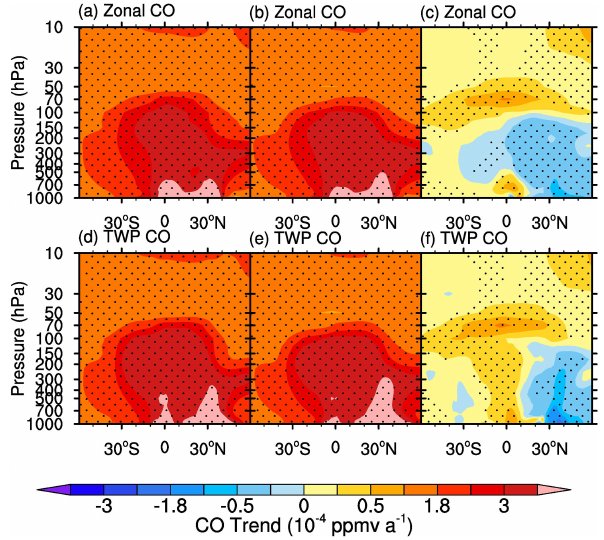
Figure 10. Latitude pressure cross sections of the trends of (a–c) the zonal mean CO concentration (10 − 4 ppmva − 1 ) and (d–f) CO concentration (10 − 4 ppmva − 1 ) over the TWP (100–180 ◦ E) in ND- JFM during 1958–2017 in the Control simulation and Fixsst simula- tion, as well as their difference. Panels (a) and (d) are the CO trends in the Control simulation. Panels (b) and (e) are the results in the Fixsst simulation. Panels (c) and (f) are the results derived from the difference between the Control and Fixsst simulations. The trends over the dotted regions are statistically significant at the 95% con- fidence